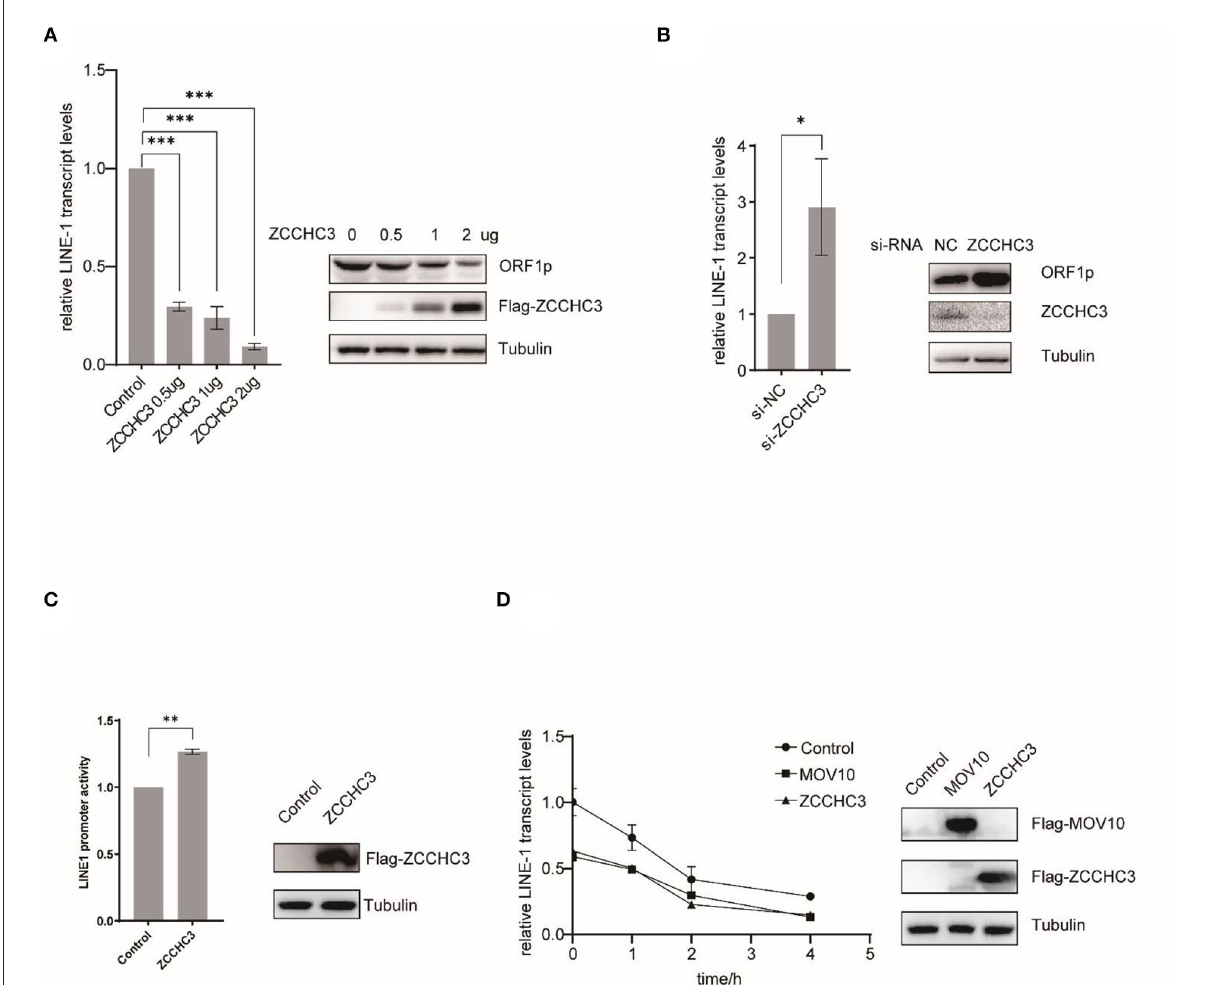
FIGURE3 ZCCHC3 diminished LINE-1 RNA and ORF1p. (A) Overexpression of ZCCHC3 decreases LINE-1 RNA and ORF1p. HEK293T cells were transfected with pWA367 and ZCCHC3 DNA. Total RNA was extracted for Taqman real-time PCR analysis, the RNA level was normalized to GAPDH (left panel). Expression of the LINE-1 ORF1p and Flag-ZCCHC3 were analyzed by immunoblot, and Tubulin was detected as an internal control (right panel). (B) Knockdown of ZCCHC3 increases LINE-1 RNA and ORF1p level. HEK 293T cells were transfected with pWA367 together with the siRNA targeting ZCCHC3. Total RNA was extracted for Taqman real-time PCR analysis, the RNA level was normalized to GAPDH (left panel). Expression of the LINE-1 ORF1p and ZCCHC3 were analyzed by immunoblot, and Tubulin was detected as an internal control (right panel). (C) ZCCHC3 does not affect the activity of the LINE-1 5 ′ UTR promoter. HEK293T cells were transfected with the L1-FL reporter plasmid and ZCCHC3 DNA. Cell lysates were analyzed for luminescence (left panel). Expression of the ZCCHC3 was analyzed by immunoblot, and Tubulin was detected as an internal control (left panel). (D) The detection of RNA stability. HEK293 cells were co-transfected with pWA367 and either ZCCHC3, MOV10 DNA, or pcDNA3.0. Twenty-four hours post-transfection, the cells were treated with actinomycin D, and then detected LINE-1 RNA levels at various times as indicated by Taqman real-time PCR, the RNA level was normalized to GAPDH (left panel). Expression of the ZCCHC3 and MOV10 were analyzed by immunoblot, and Tubulin was detected as an internal control (left panel). Data are representative of at least three independent experiments, values are expressed as means ± SD, and representative blots and images are shown.